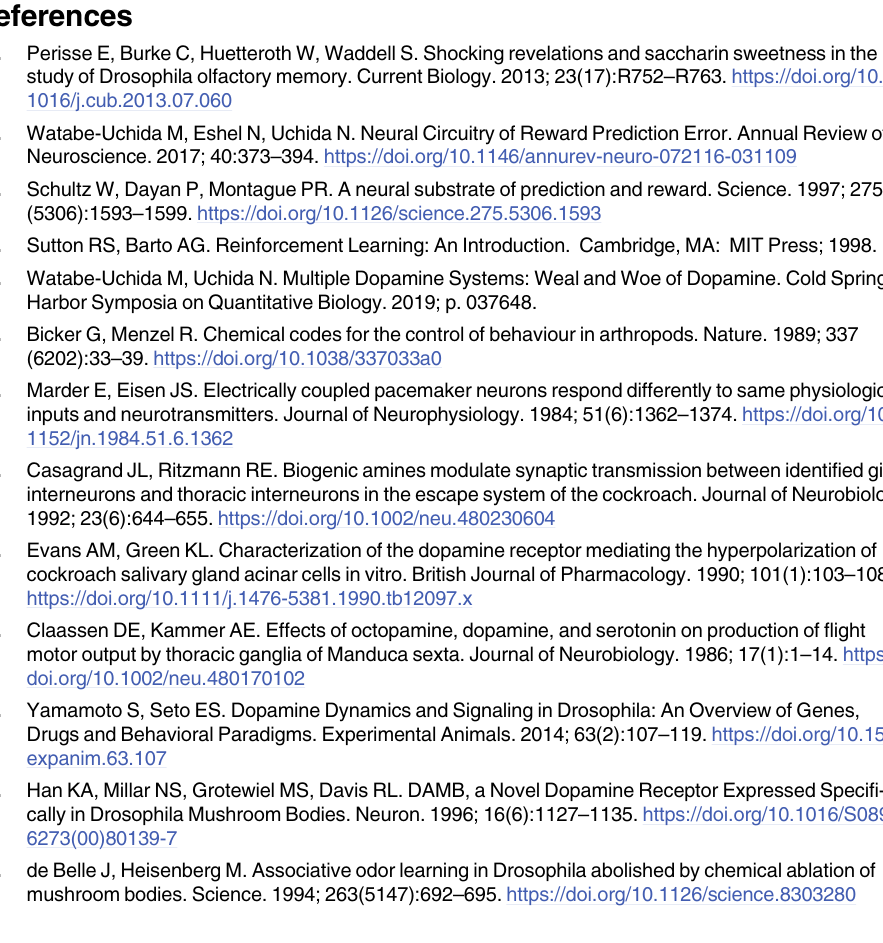
S7 Fig. Example cross-correlation functions between dopamine neuron activity and veloc- ity during navigation. Left: Expectation of d ( t ) u ( t + τ ), where d ( t ) is dopamine neuron activity and u ( t ) is forward velocity. Each color represents a different dopamine neuron. Right: Same as left, but for d ( t ) ω ( t + τ ), where ω ( t ) is angular velocity.